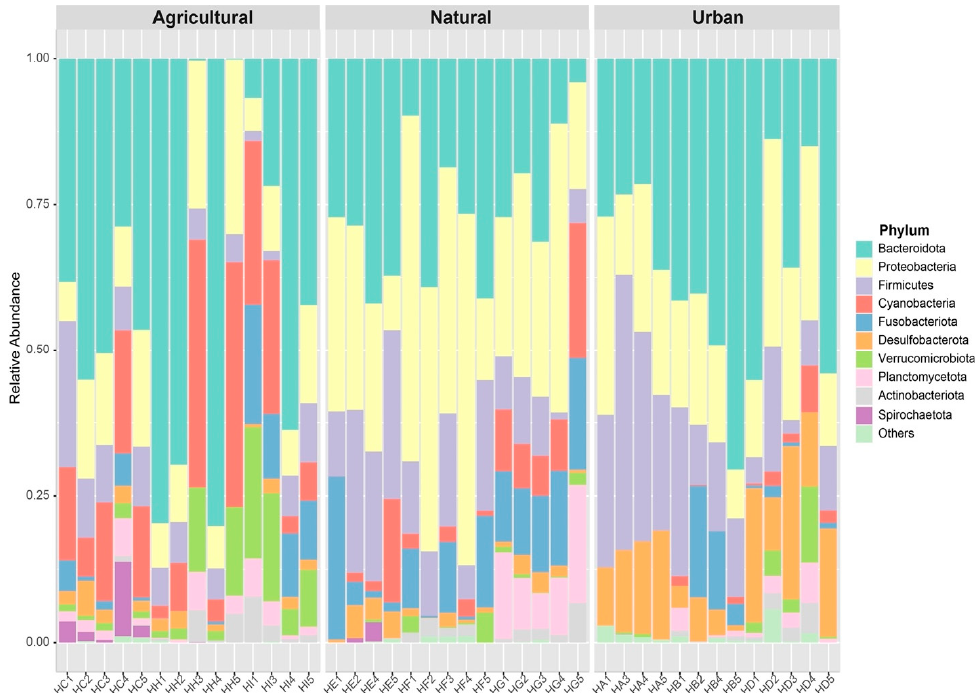
Figure 1. Relative abundance of bacterial phyla found in the guts of tadpoles collected from 9 ponds across three different habitat types. Sample names on the X ‐ axis are individual tadpole identifiers.